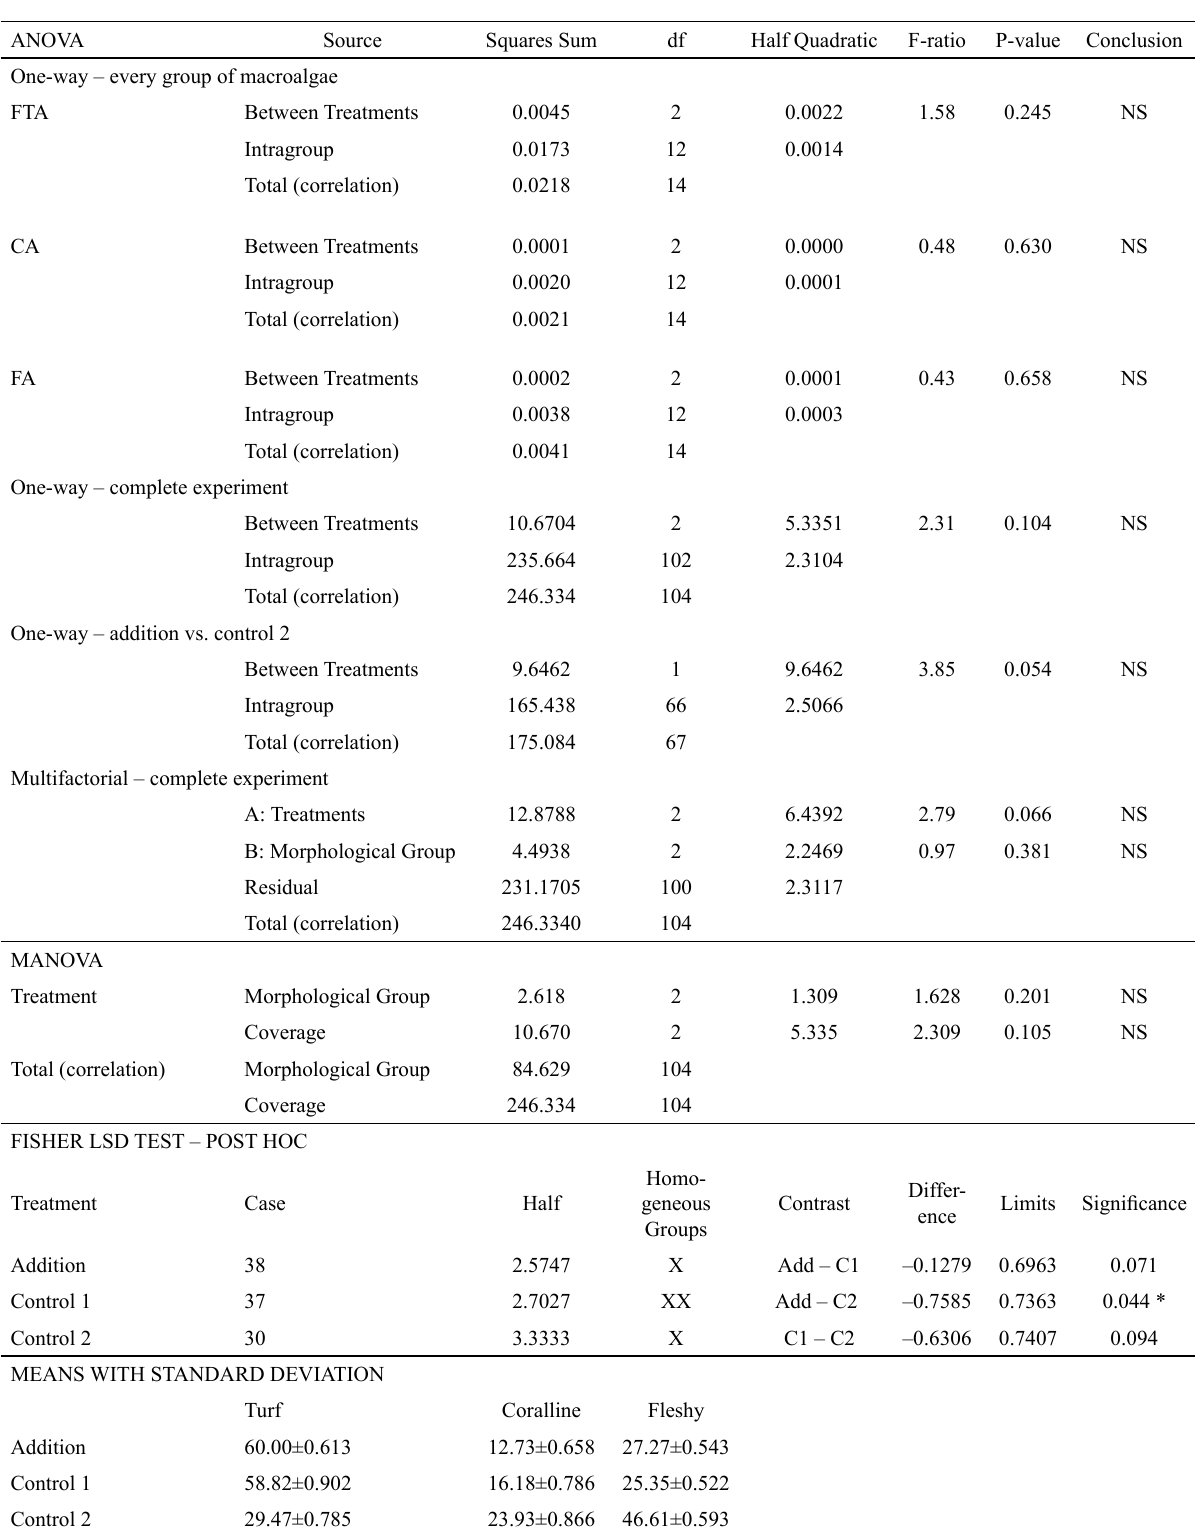
Table 2. – Results of a one-way and multifactorial analysis of variance (ANOVA) on the coverage of species between treatments, a multivariate analysis of variance (MANOVA), a Fisher LSD test and the means with standard deviation for each treatment and morphological group. FTA, filamentous turf algae; CA, coralline algae; FA, fleshy algae; NS, no significance. ANOVA Source Squares Sum df Half Quadratic F-ratio P-value